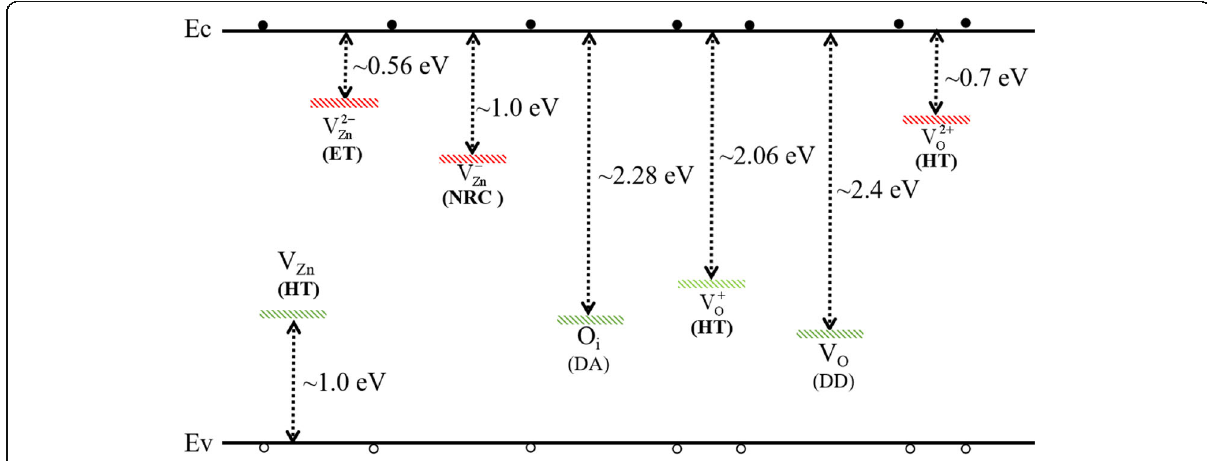
Fig. 4 The schematic diagram of the energy level of V O , V Zn , and Oi-related defects collected from references. NRC, non-radiative recombination center; ET, electron trap; HT, hole trap. Liu et al.